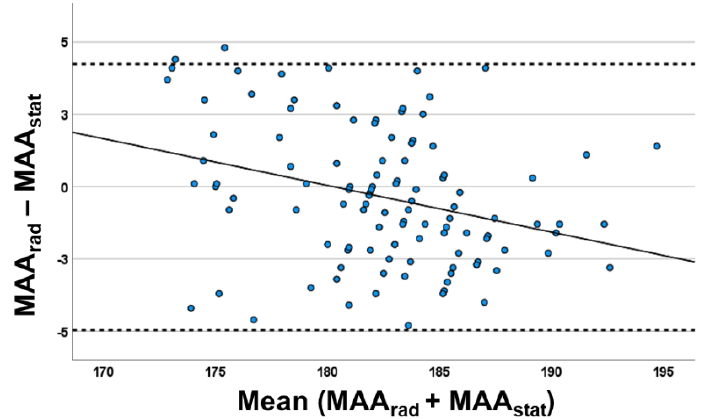
Figure 3. Bland–Altman plot between static marker-based (MAA stat ) and radiographic leg axis (MAA rad ) and evaluation ( n = 102) with: X -axis valgus alignment (<180°) and varus alignment (>180°); Y -axis: according to the MAA rad – MAA stat calculations, the positive values represent the cases for which MAA rad values were greater than those calculated with MAA stat and the negative values represent the cases for which MAA stat values were greater than those calculated with MAA rad . The systematic bias of both methods is 2.35°.